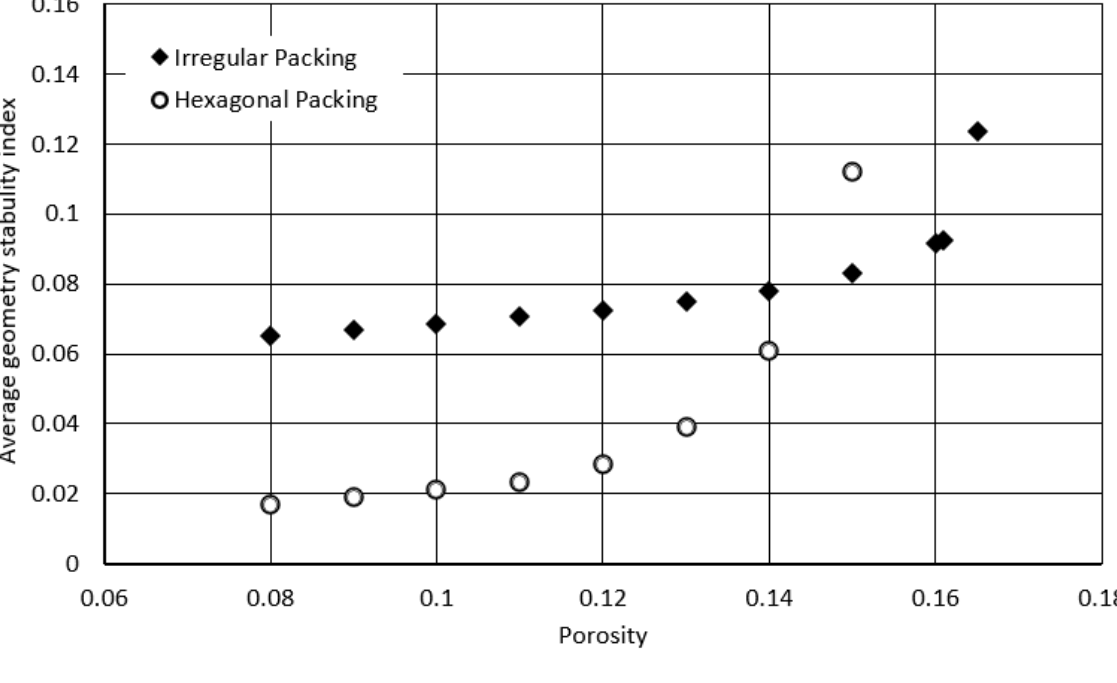
Figure 16. Average geometry stability index with porosity.